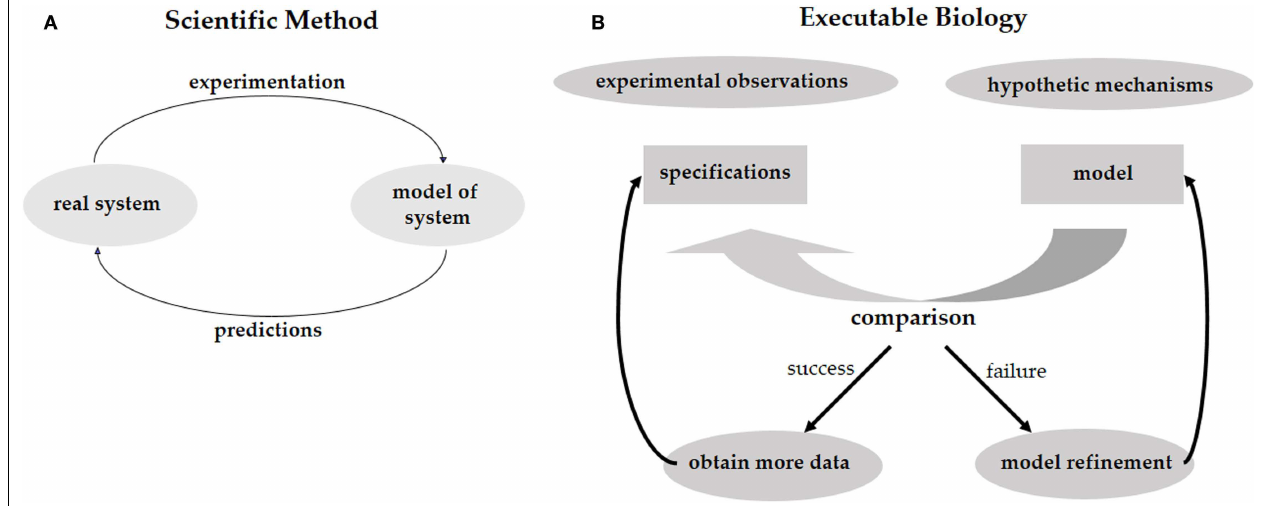
FIGURE 1 | (A) The scientific method calls for the elaboration of a predictive model of the system under study.The model should reproduce the existing experimental results and should be predictive regarding future experiments. By performing these experiments we validate the model, or refine it to a better model that captures more facts about the system. (B) The same